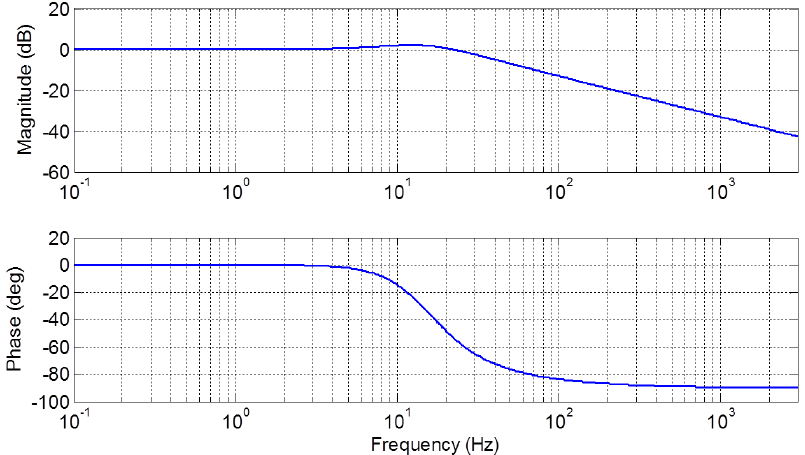
Figure 3. Bode plot of the synchronous reference frame phase-locked loop